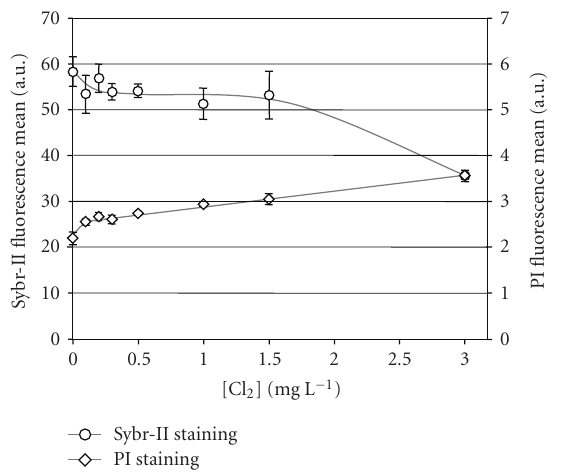
Figure 2: Mean fluorescence of Salmonella typhimurium cells stained either by SYBR-II ( ) or by PI ( ) versus initial applied [Cl 2 ] (mgL − 1 ) (22 ± 1 ◦ C).